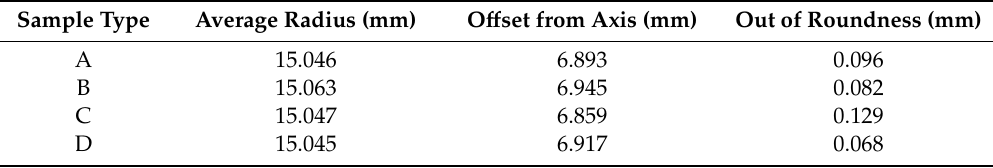
Table 1. Average radius, offset from the axis, and out-of-roundness of the cross sections perpendicular to the spindle axis